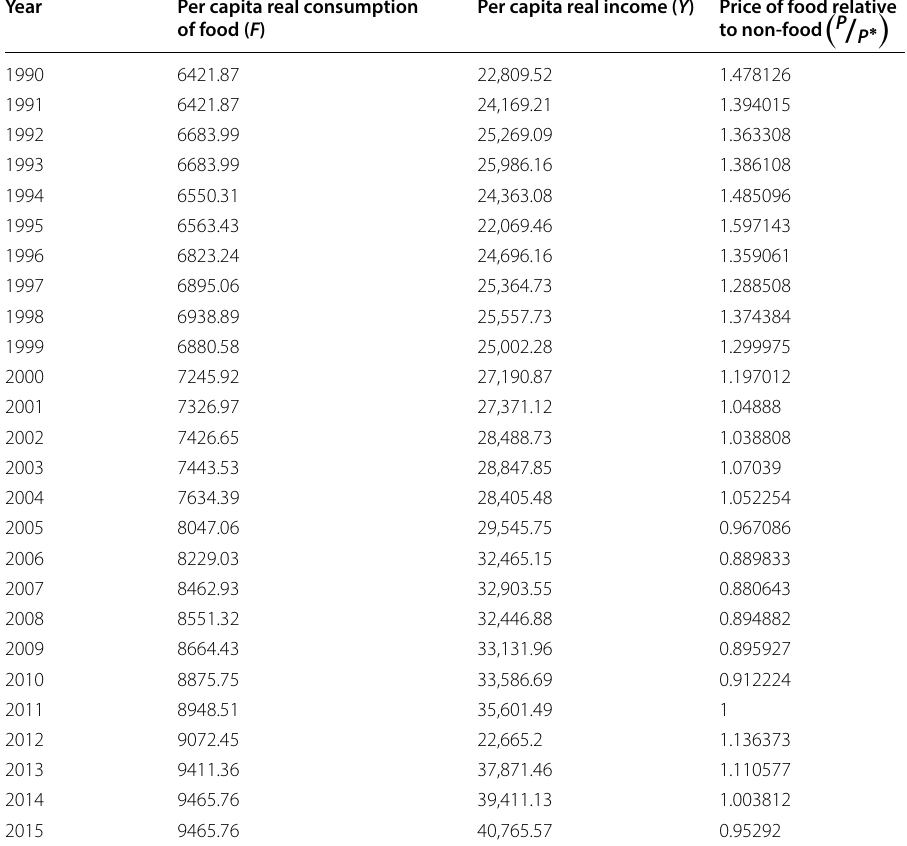
Table 1 Time series data for food demand function in Iran